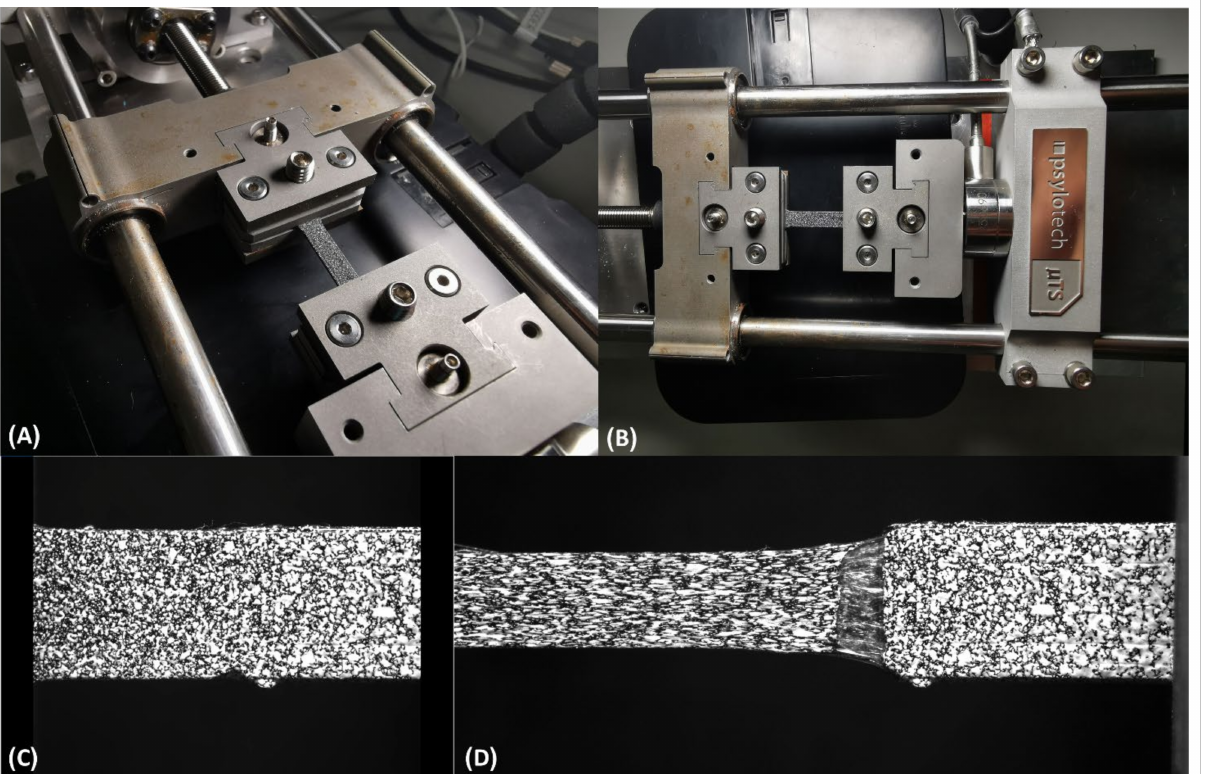
Figure 3. Combined stiff and compliant samples under tensile test with DIC. ( A , B ) Random-colored samples under tensile test for DIC post-processing. Speckle pattern of the TPU-PETG sample- before ( C ) and after ( D ) tension